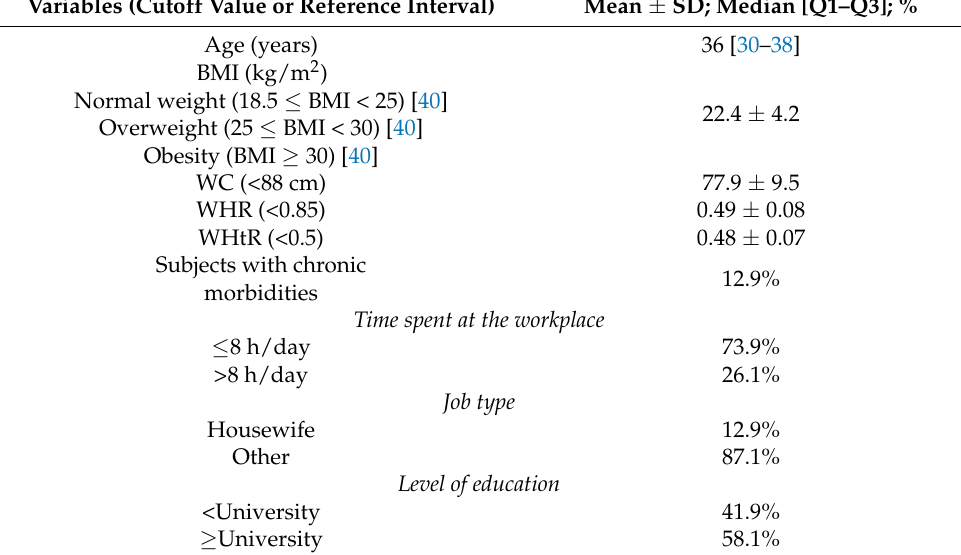
Table 2. General characteristics of women included in the study ( n = 45). Data were reported as mean ± standard deviation (SD) or median and interquartile range [Q1–Q3] or frequency of subjects expressed as a percentage